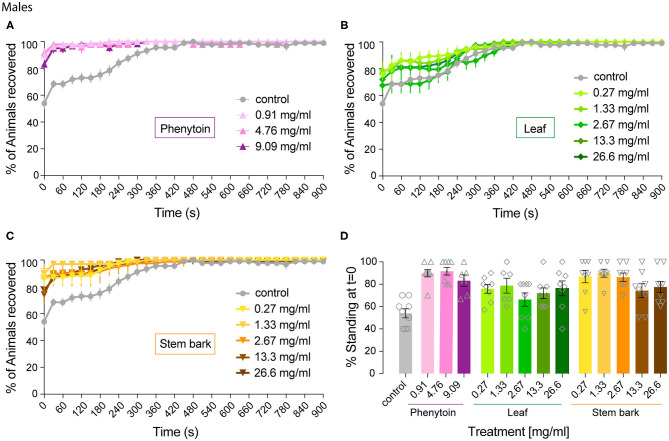
Effect of phenytoin and A. senegalensis extracts on recovery from seizures of parabss males. Mechanical stimulation of parabss control male flies induced a seizure-like phenotype that was less penetrant than in females. The effects of phenytoin (A), A. senegalensis leaf (B) or stem extract (C) are shown. (D) Dose response analysis at t = 0 for all treatments. Graphs show the mean % of flies seizuring ± SEM (for number of replicates, flies and significance see Table 1).